Question: Express in one sentence what the figure is showing.
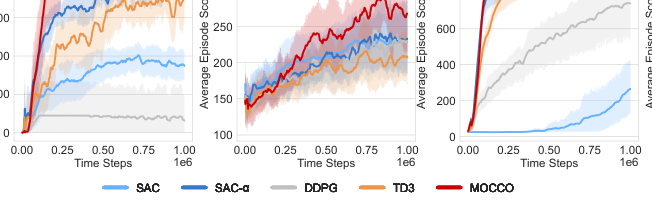
Answer: Learning curves of evaluation algorithms.